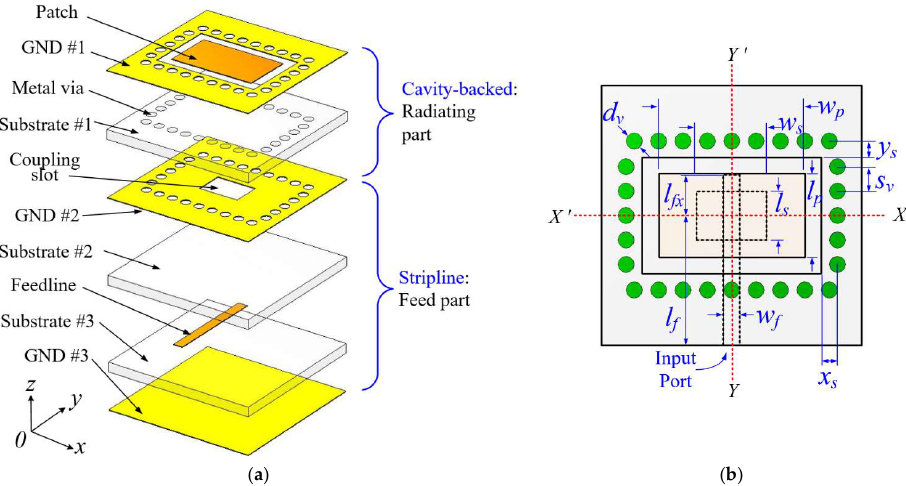
Figure 1. The geometry of element antenna: ( a ) 3D exploded view and ( b ) top view.